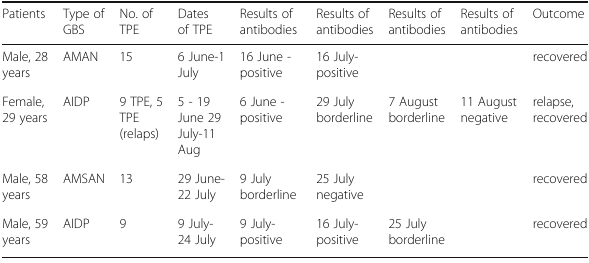
Table 43 (abstract A119). Patients with GBS Patients Type of GBS